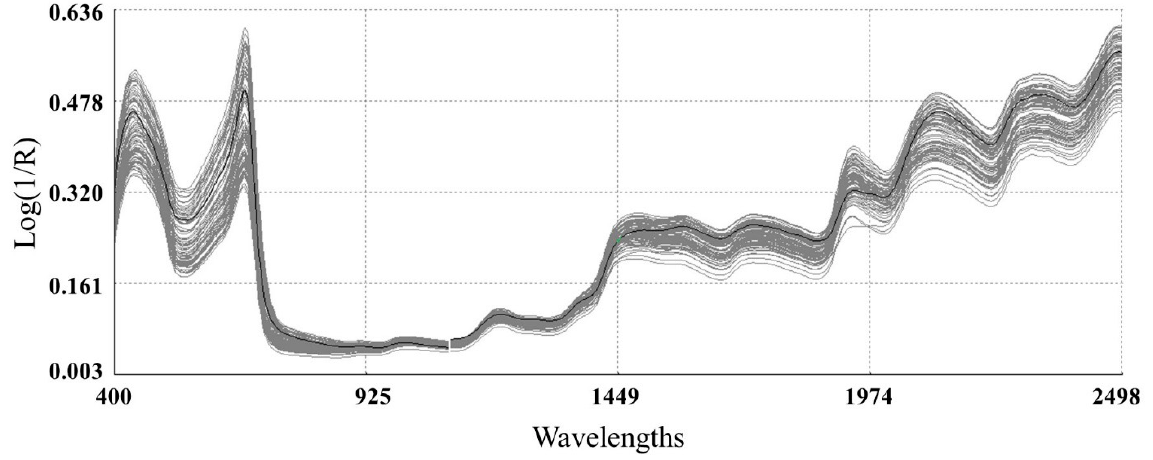
Figure 5. Raw spectra for dried mangetout samples.